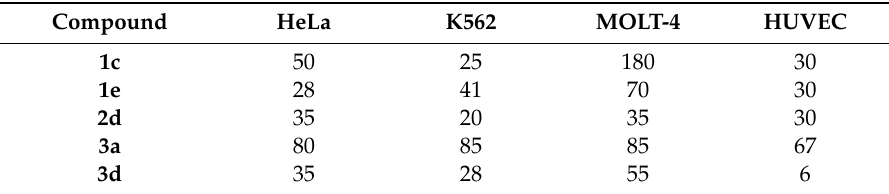
Table 2. The IC 50 values [ µ M] after 48 h incubation with cells.